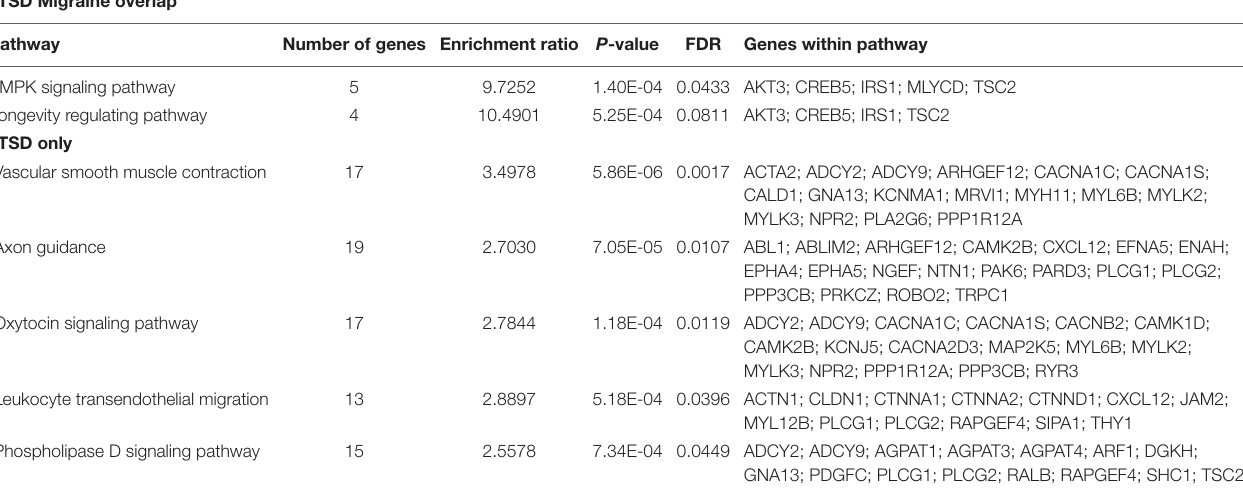
FIGURE 5 | Boxplots of overlapping genes: box plots of PTSD associated genes overlapping in migraine. The mean DNA methylation is higher in PTSD than in controls for all the overlapping genes in migraine except for SPOPL and C1orf187. TABLE 5 | Biological pathways overrepresented among genes associated among genes associated with PTSD (only) and genes associated with both PTSD and